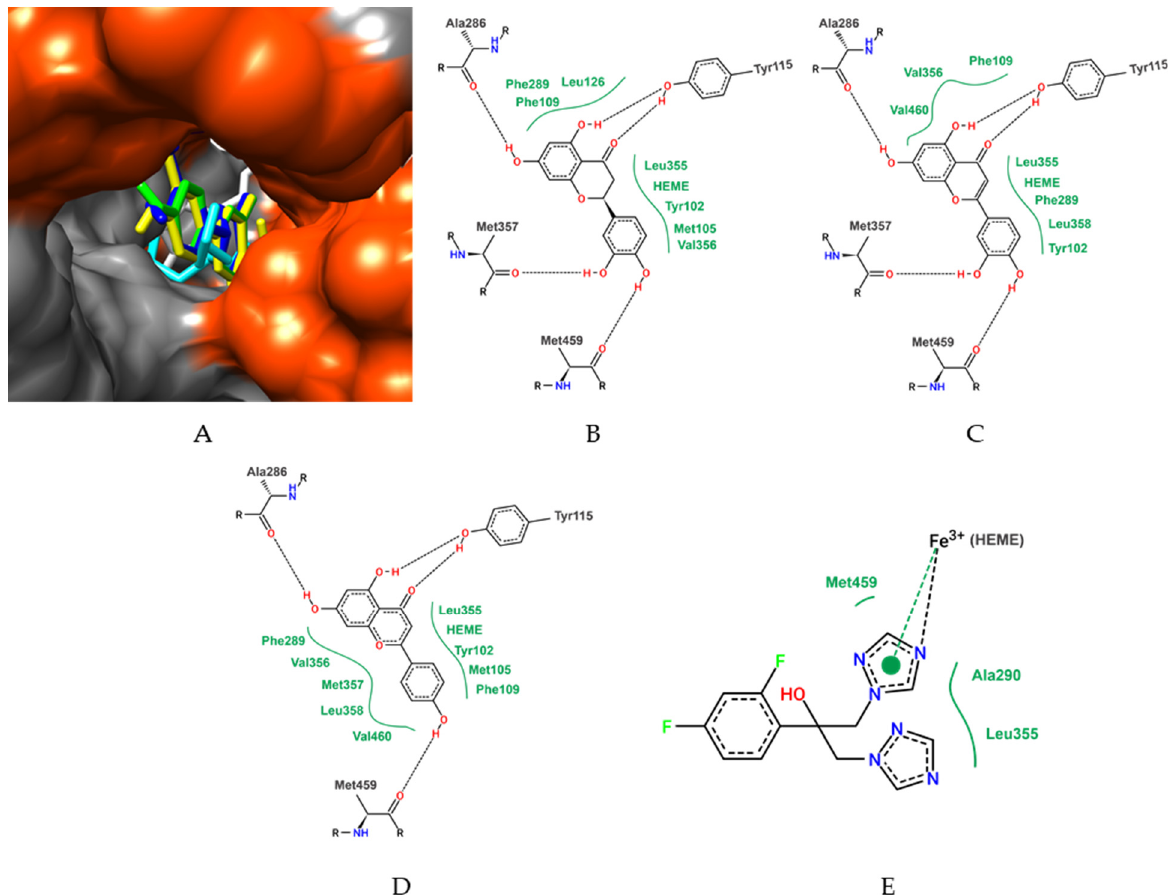
Figure 2. Detailed representation of conformations obtained by molecular docking of eriodictyol (blue), luteolin (yellow), apigenin (green), fluconazole (cyan), and HEME group (white) at the LiCYP51 active site ( A ). Two-dimensional diagram of the interactions performed by eriodyctiol ( B ), luteolin ( C ), apigenin ( D ) and fluconazole ( E ) with the amino acid residues and HEME group of the LiCYP51 active site. Dashed black lines represent hydrogen bonds, while full green lines represent van der Waals interactions.